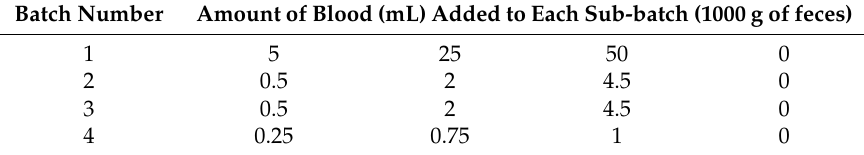
Table 1. An overview of the in vitro titration experiment for identification of the detection limit of two fecal occult blood tests. Batches 2 and 3 were similar in volumes of blood, and they were made to investigate if pooling the fecal matter from di ff erent cows had an impact on the